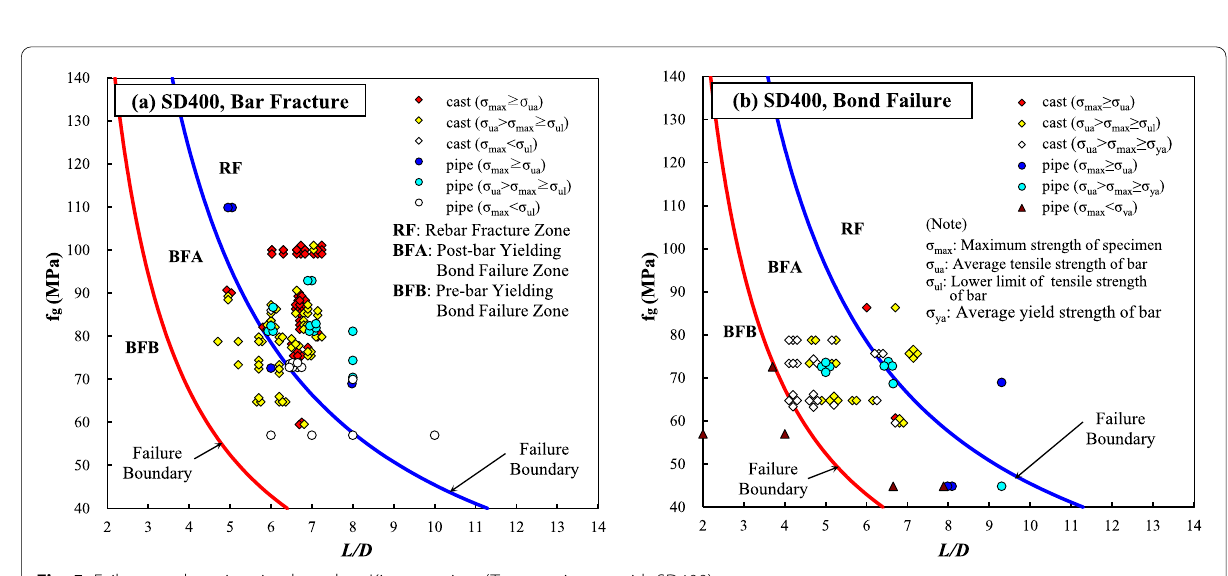
Fig. 5 Failure mode estimation based on Kim equation. (Test specimens with